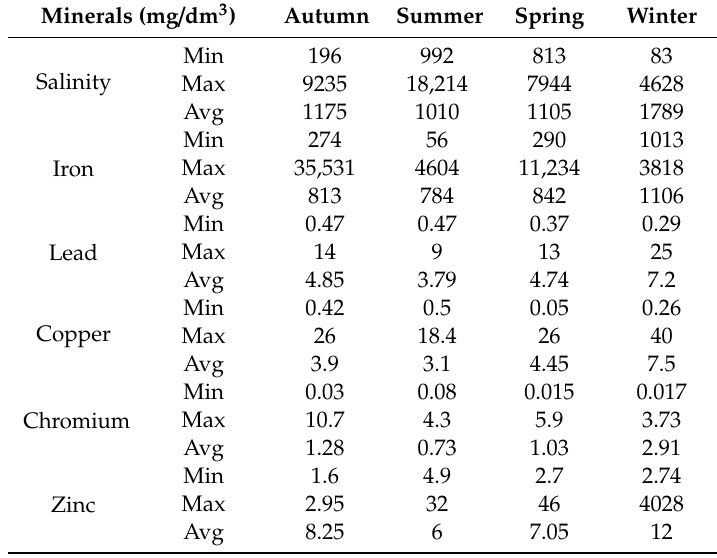
Table 3. Evaluated soil quality parameters values from images during four seasons of